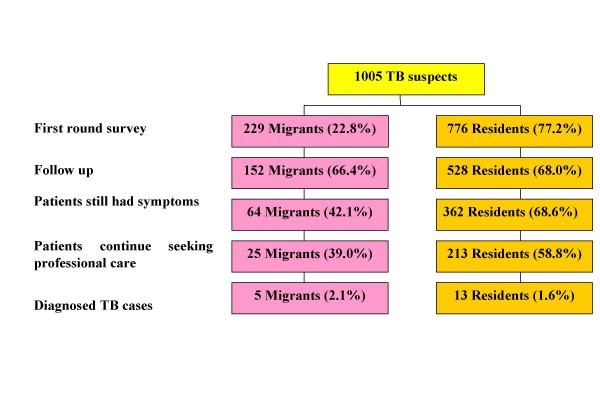
Progress in diagnosis by TB suspects. The flow chart shows the progress in diagnosis by TB suspects among migrants and residents over the time of the two surveys conducted. In the following up, only 39% of the migrants who were still suffering from the symptoms continued seeking professional care, compared to 59% of the residents.